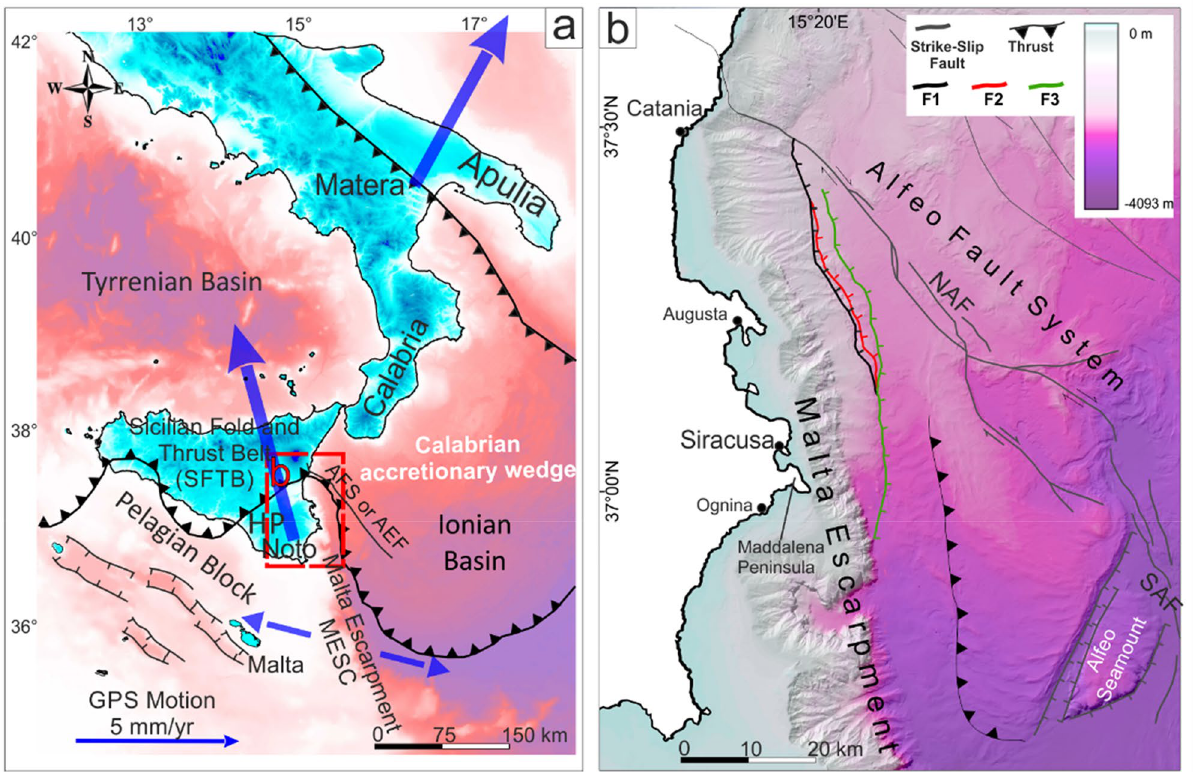
Figure 1. ( a ) Tectonic sketch map of southern Italy. Large blue arrows indicate the GPS vectors (see 14–16 , modified after Gambino et al. 26 ) in the lower plate of the collisional system whereas small blue arrows is the resultant extension in the Western Ionian Basin. AFS, Alfeo Fault System 17,18 ; AEF, Alfeo-Etna Fault 19 ; ( b )